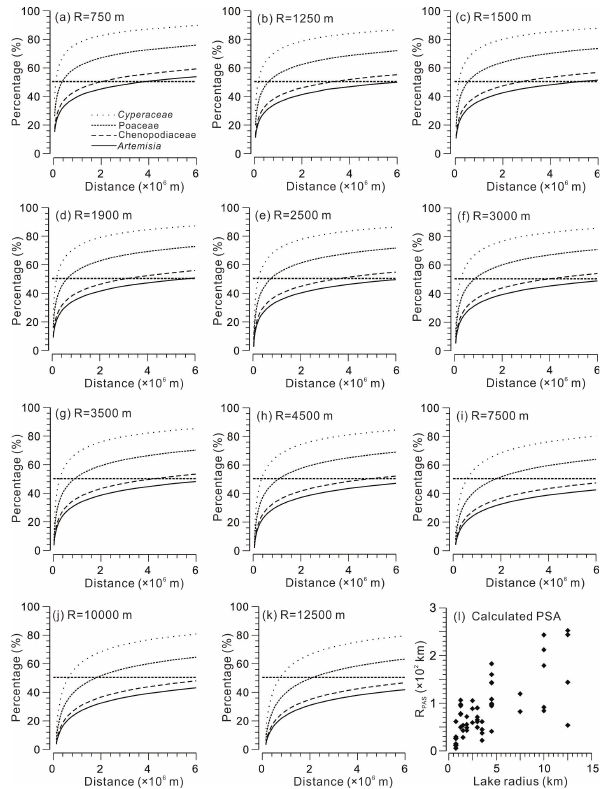
Fig. 3. (a–k) : establishment of pollen source areas for the four ma- jor pollen types ( Artemisia , Chenopodiaceae, Poaceae, and Cyper- aceae) using various lake sizes (radii ranging from 750 to 12500m), showing the changes to the proportion of pollen loading in the lake ( y axes – percentages) with increasing distance from the lake ( x axes – metres) (horizontal lines indicate the 50% levels). (l) : corre- lation of the calculated pollen source area radius with the lake radius for 53 surface sediment pollen samples from large lakes.